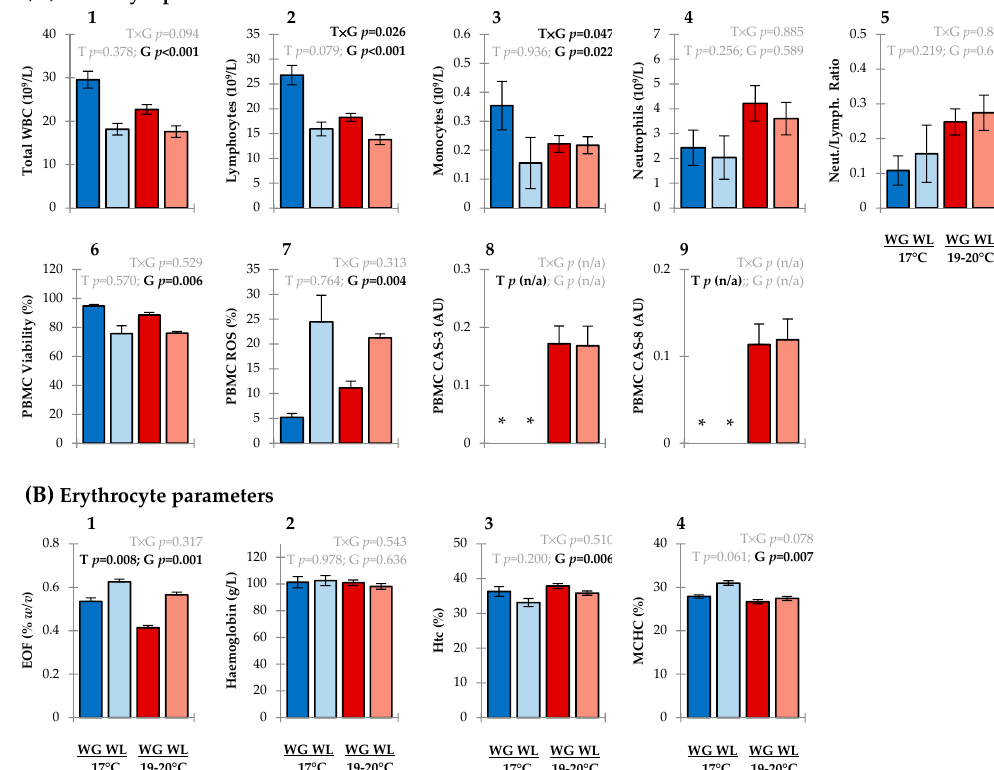
Figure 2. Cellular-based blood parameters associated with chronic thermal stress (17 ◦ C vs. 19–20 ◦ C) and growth performance (weight gain (WG) vs. weight loss (WL) phenotypes) in Oncorhynchus tshawytscha . ( A ) Leukocyte parameters; ( B ) Erythrocyte parameters. Data represent group means ± SE. Blue and red bars represent 17 ◦ C and 19–20 ◦ C treatments, respectively; darker and lighter shaded bars represent groups that gained and lost weight, respectively. Main effects of temperature (T), growth (G), and their interaction (T × G) are presented via their p -values in the upper section of each plot (generalized linear mixed models; α = 0.05). Asterisks signify non-detectable levels (statistical testing of these parameters are not applicable (n/a)).